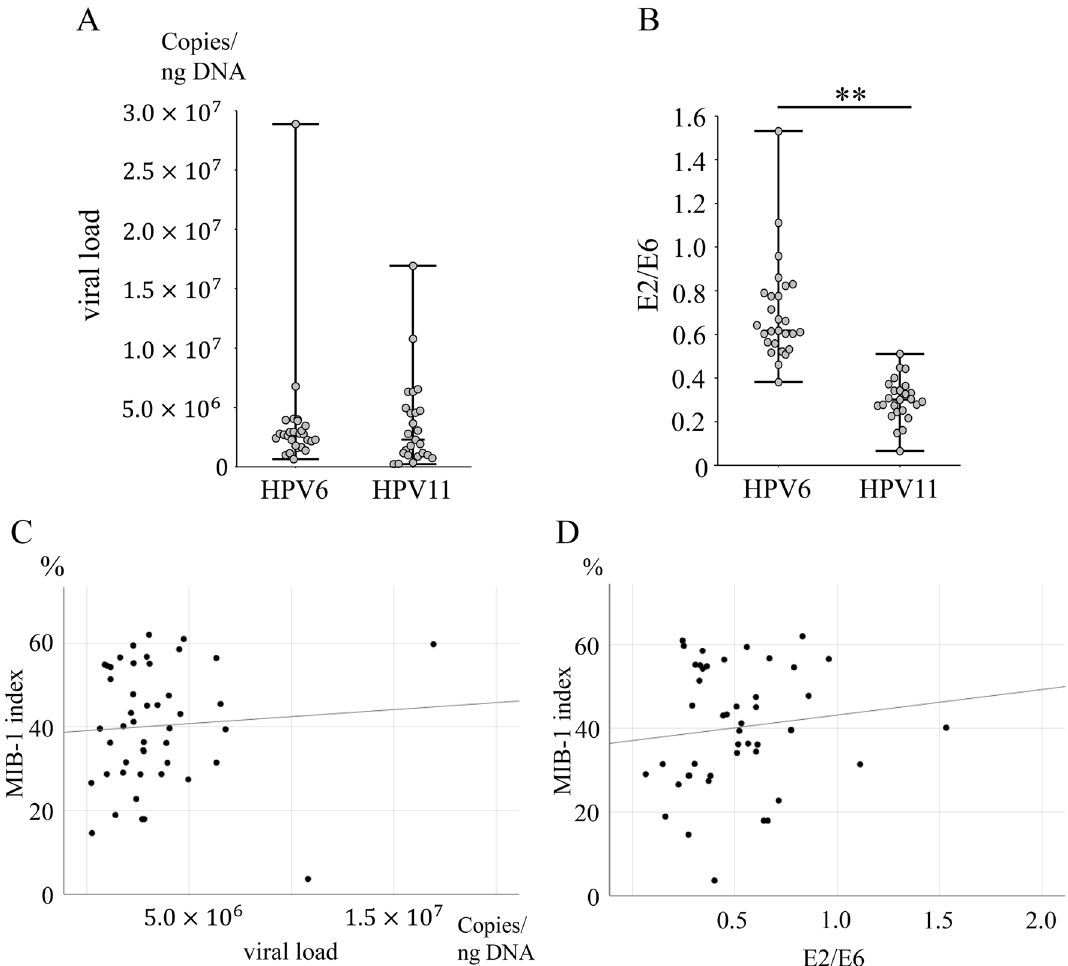
Figure 6. Assessment of HPV viral load and physical status. ( A ) Viral load shows no difference between HPV types 6 and 11 ( p = 0.96). ( B ) HPV type 11 levels are significantly lower in E2/E6 ( p < 0.01). ( C ) Viral load shows no correlation with the MIB-1 index (r = 0.07, p = 0.66). ( D ) E2/E6 shows no correlation with the MIB-1 index (r = 0.12, p = 0.44). **Indicates p < 0.01. HPV Human